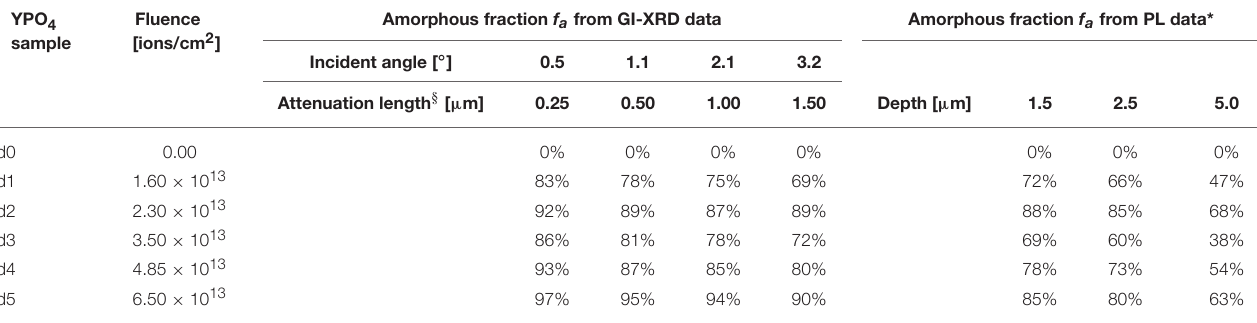
TABLE 2 | Detailed data of accumulated radiation damage in xenotime-type YPO 4 ceramics of various depths below the irradiated surface as obtained from the two independent methods grazing-incidence X-Ray diffraction and laser-induced photoluminescence (Nd 3 +